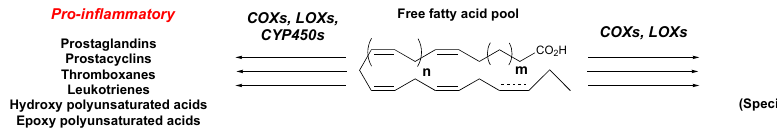
Figure 1. An outline of the different classes of oxylipins.